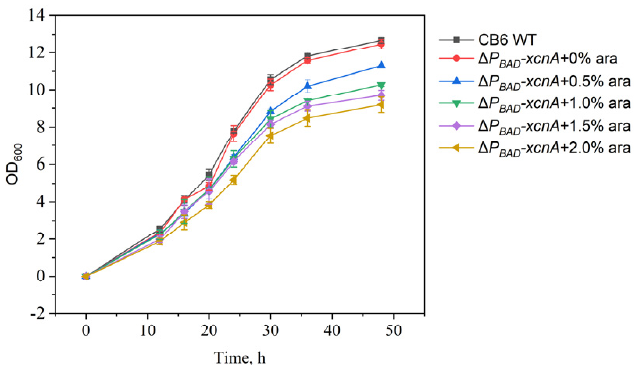
Figure 2. Growth curves of ∆ P BAD -xcnA mutant strain, adding different concentrations of L-arabinose and wildtype CB6 strain.